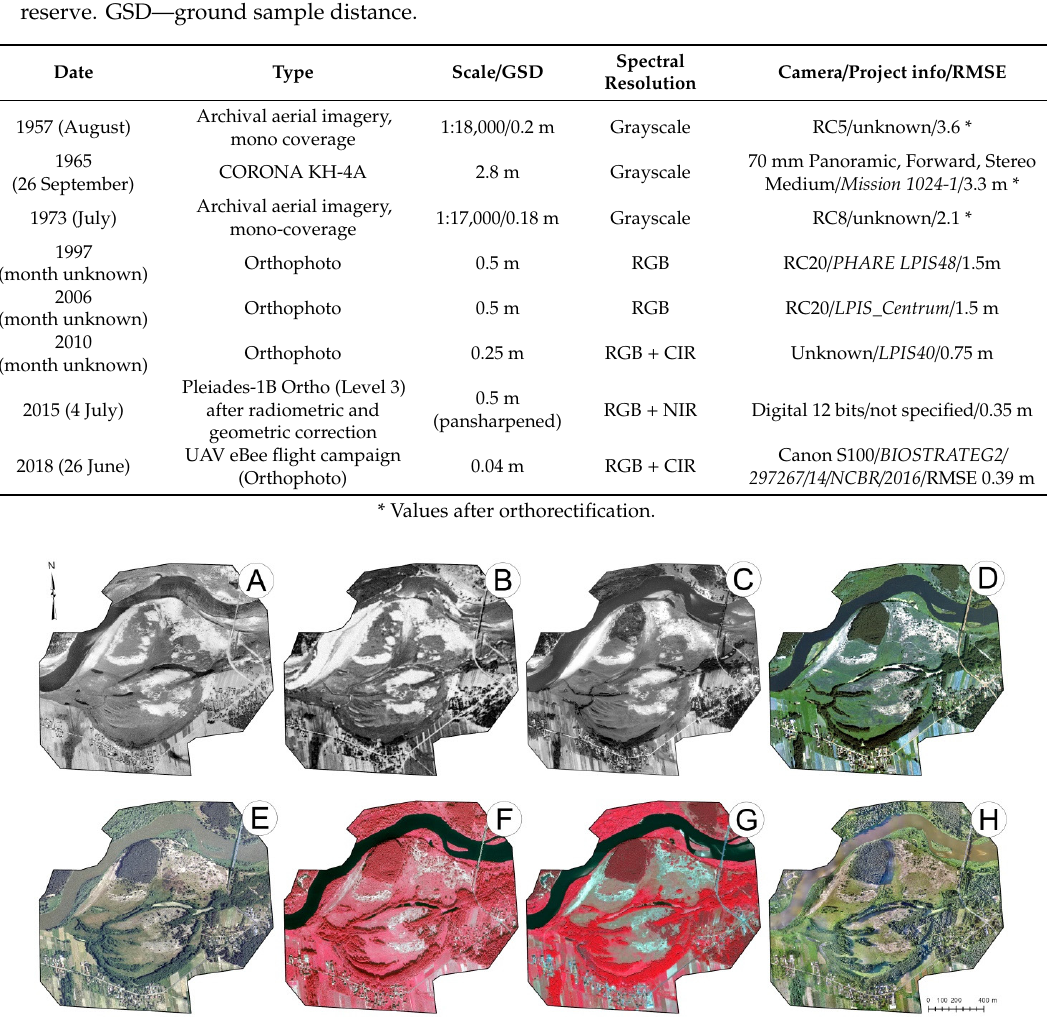
Table 1. The list of remote sensing imagery used for a multi-temporal case study of “Kózki” nature reserve. GSD—ground sample distance.